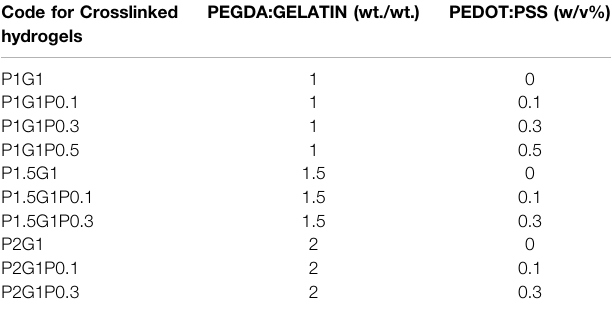
TABLE 1 | Compositions of the fi nal solutions exploited for the preparation of the different PEGDA-gelatin/PEDOT:PSS hydrogels, which corresponding codes are reported in the fi rst